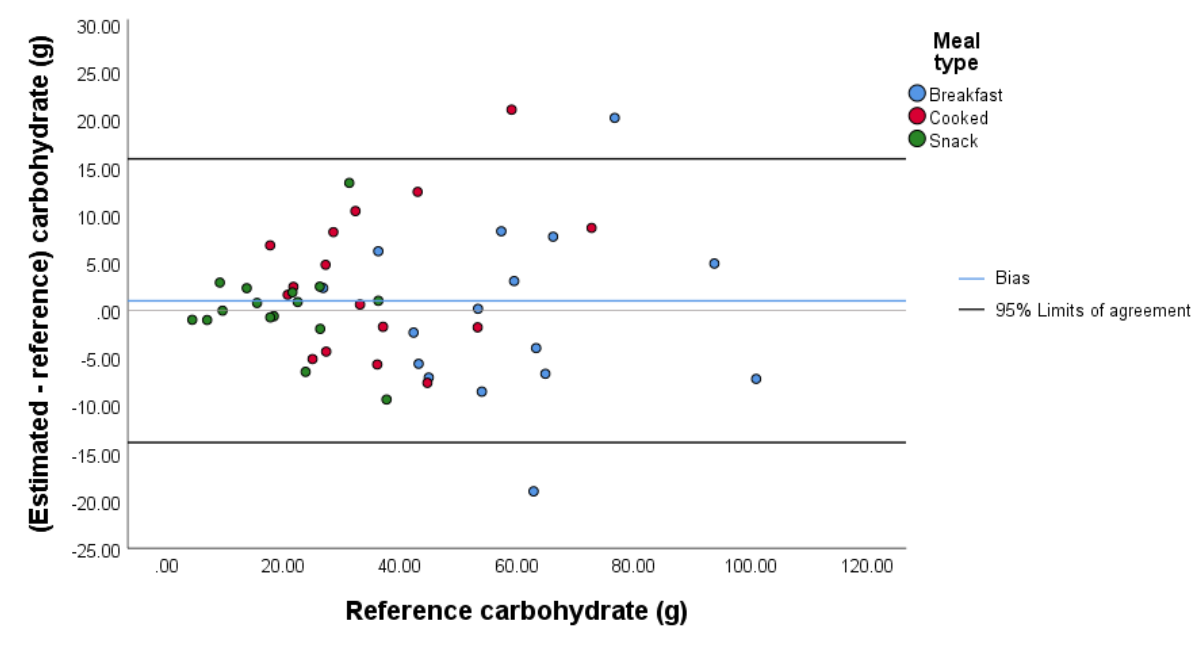
Figure 3. Bland-Altman plot illustrating the difference between the estimated and reference carbohydrate content of the